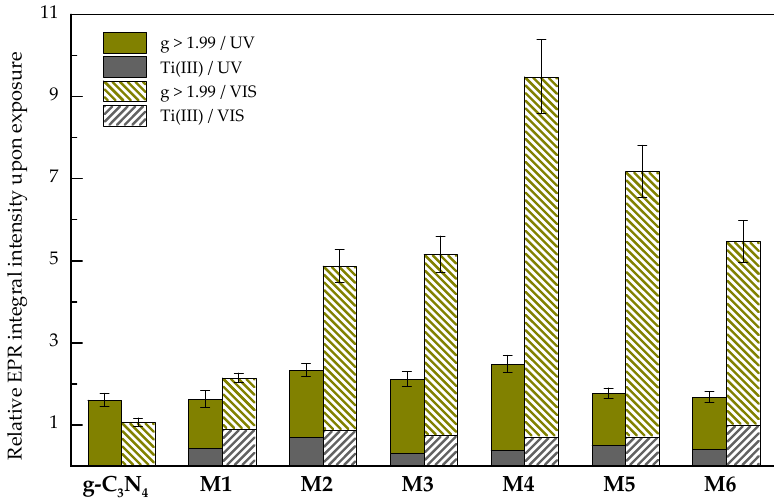
Figure 4. Relative EPR integral intensity upon 7 ‐ min VIS ‐ light (160 klx) and UV ( λ max = 365 nm; irradiance 20 mW cm –2 ) exposure, elucidated from X ‐ band EPR spectra of pristine g ‐ C 3 N 4 and M1–M6 nanopowders measured at 100 K.